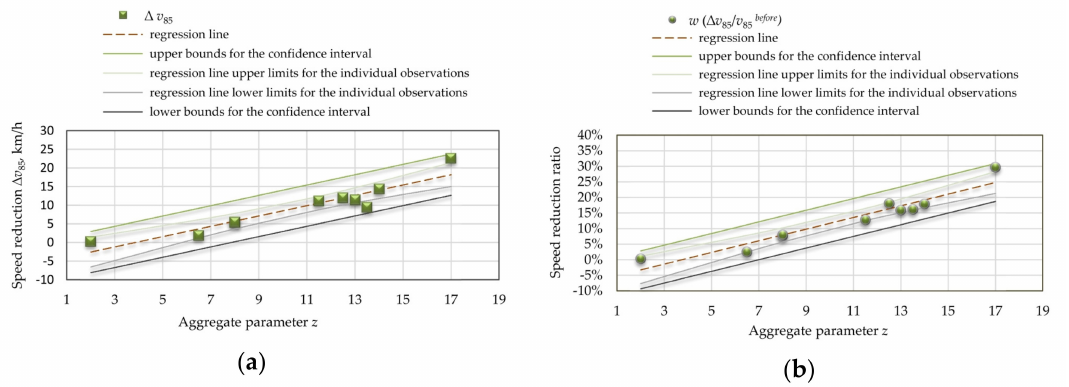
Figure 14. Compilation of changes in the analysed variables: ( a ) consistency of variations in speed reduction ∆ v 85 and ∆ v av , and the aggregate parameter z ( R = 0.94 and R = 0.96, respectively); ( b ) consistency of variations in speed reduction index w ( v 85 ) and w ( v av ) and aggregate parameter z ( R = 0.92 and R = 0.93, respectively).